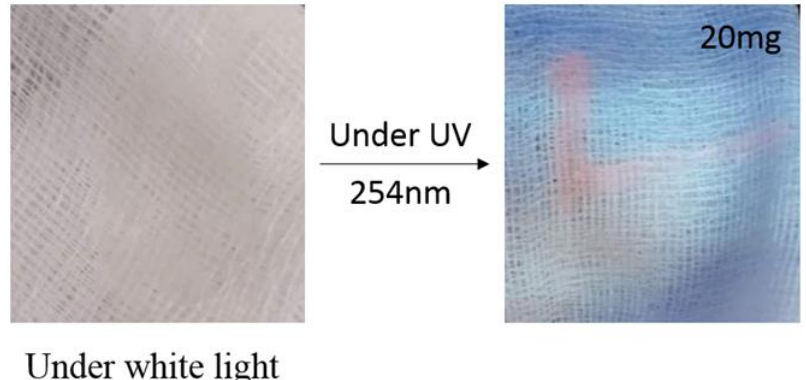
Figure 6. Demonstration of the visibility of our luminescent ink.